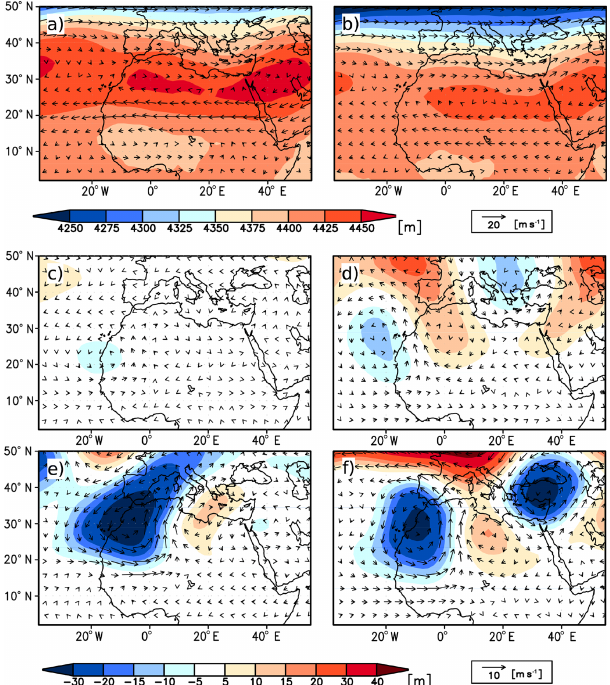
Figure A3. Monthly mean geopotential height at 850hPa (m, shaded) and wind at 850hPa (ms − 1 , vector) for (a) 7ka Septem- ber and (b) 7ka October. (c, d) Differences in 850hPa geopoten- tial height (m, shaded) and 850hPa wind (ms − 1 , vector) between the composite of all rain events occurring in the coastal area (15– 11 ◦ W, 20–25 ◦ N) and the monthly mean flow for (c) 7ka Septem- ber, (d) 7ka October; and (e, f) differences between the composite of all rain events in the western Sahara (20–35 ◦ N, 10 ◦ W–10 ◦ E) and the monthly mean flow for (e) 7ka September and (f) 7ka Oc- tober. The months have been adjusted to the fixed-angular